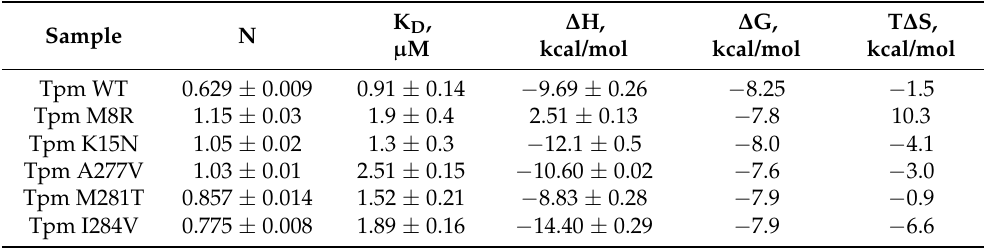
Table 5. Thermodynamic parameters of the interaction of TnT1 (as a ligand) with Tpm mutants at 25 ◦ C determined by